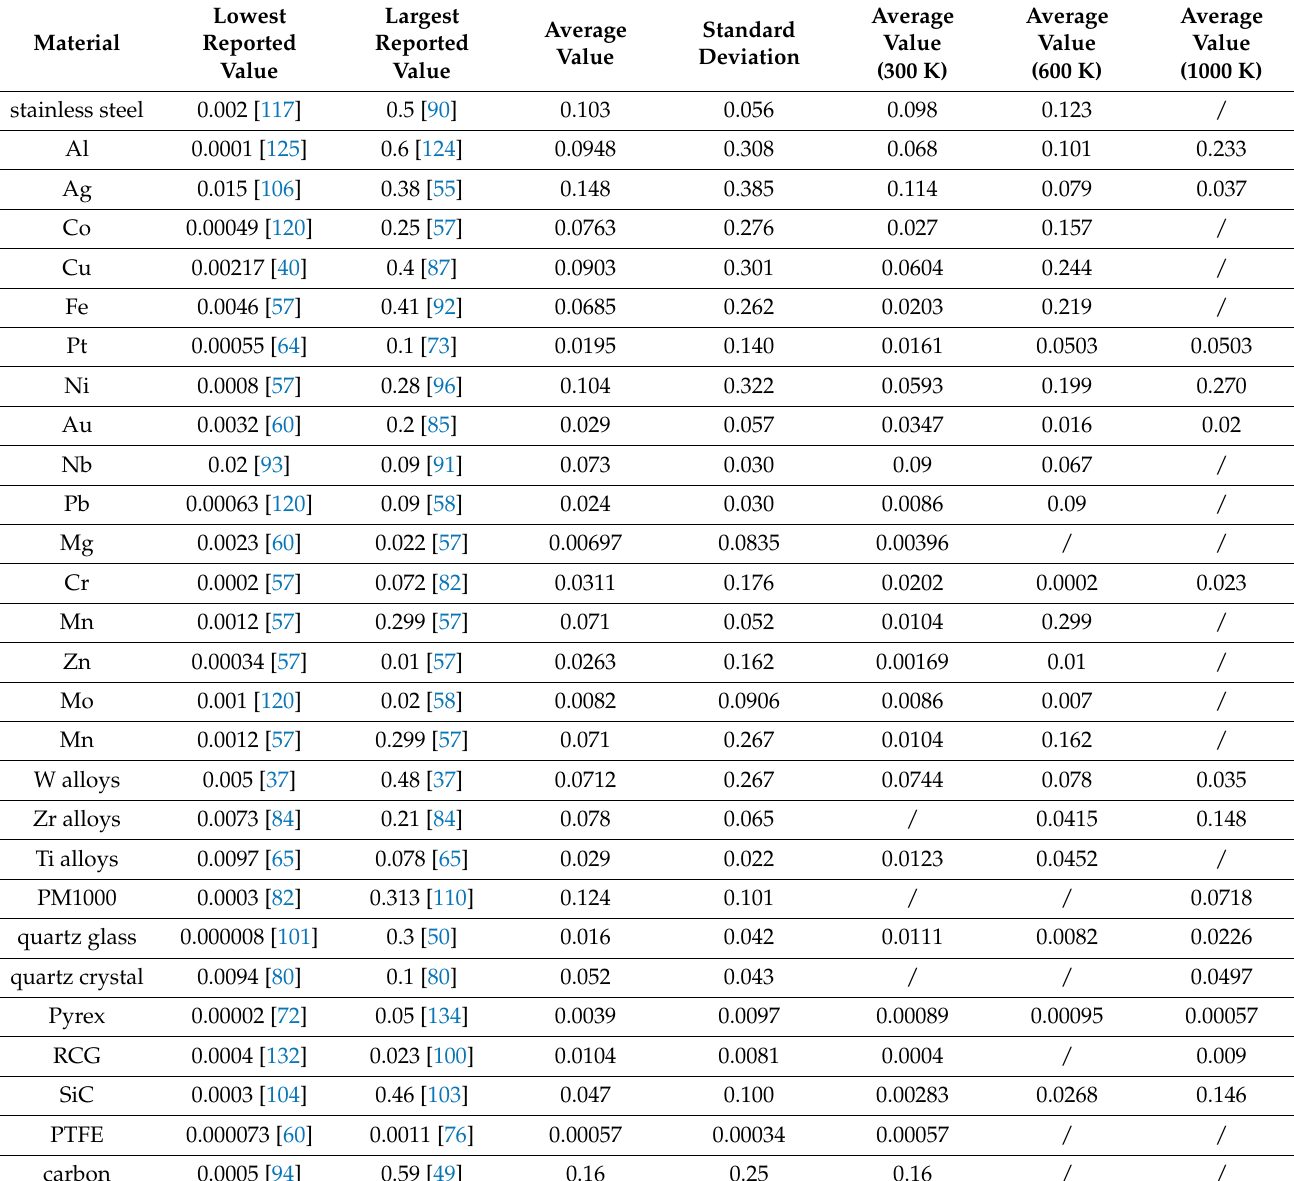
Table 4. Recombination coefficient values reported for various materials and their composites. Along with the lowest and highest values reported, average values and standard deviations were calculated (where possible). Materials were grouped together with their oxides, as were certain